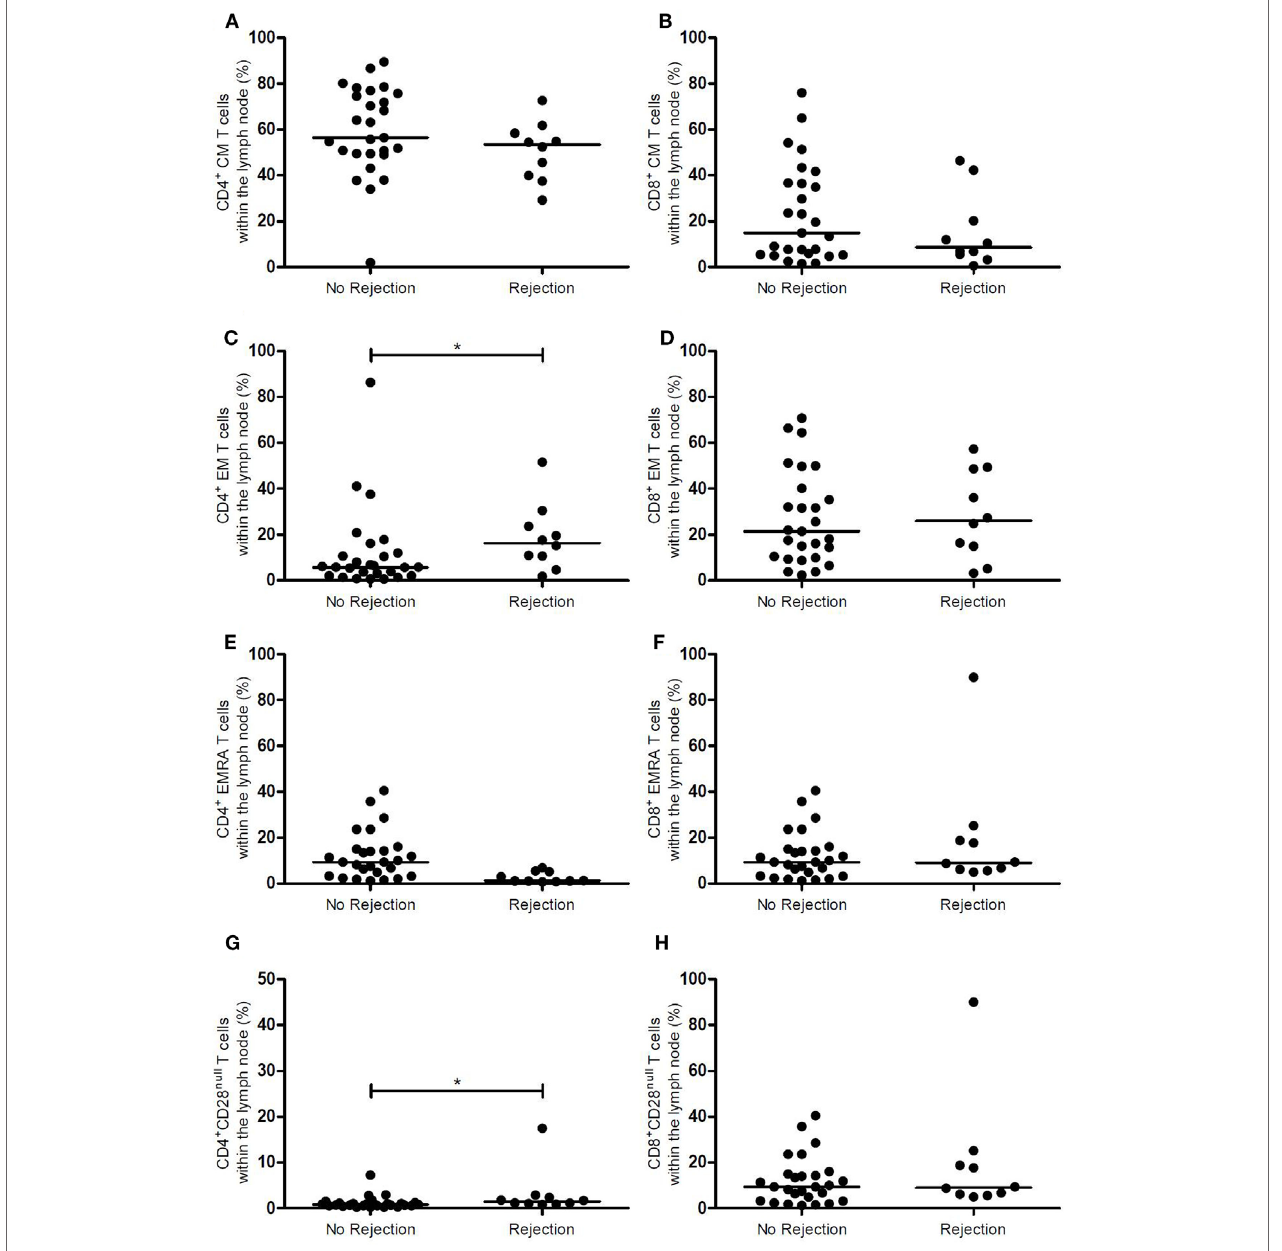
FigUre 2 | Memory CD4 + and CD8 + T-cell subsets and CD28 expression in the lymph node between rejection and no rejection groups. (a) Frequencies of CD4 + CM T cells, (B) CD8 + CM T cells, (c) CD4 + EM T cells, (D) CD8 + EM T cells, (e) CD4 + EMRA T cells, (F) CD8 + EMRA T cells, (g) CD4 + CD28 null T cells, and (h) CD8 + CD28 null T cells within the lymph nodes are shown between the no rejection and rejection groups. Data are presented with individual percentages and medians. Significant differences were calculated and shown (* p < 0.05, ** p ≤ 0.01, *** p ≤ 0.001). CM, central memory; EM, effector memory; EMRA, effector memory CD45RA +